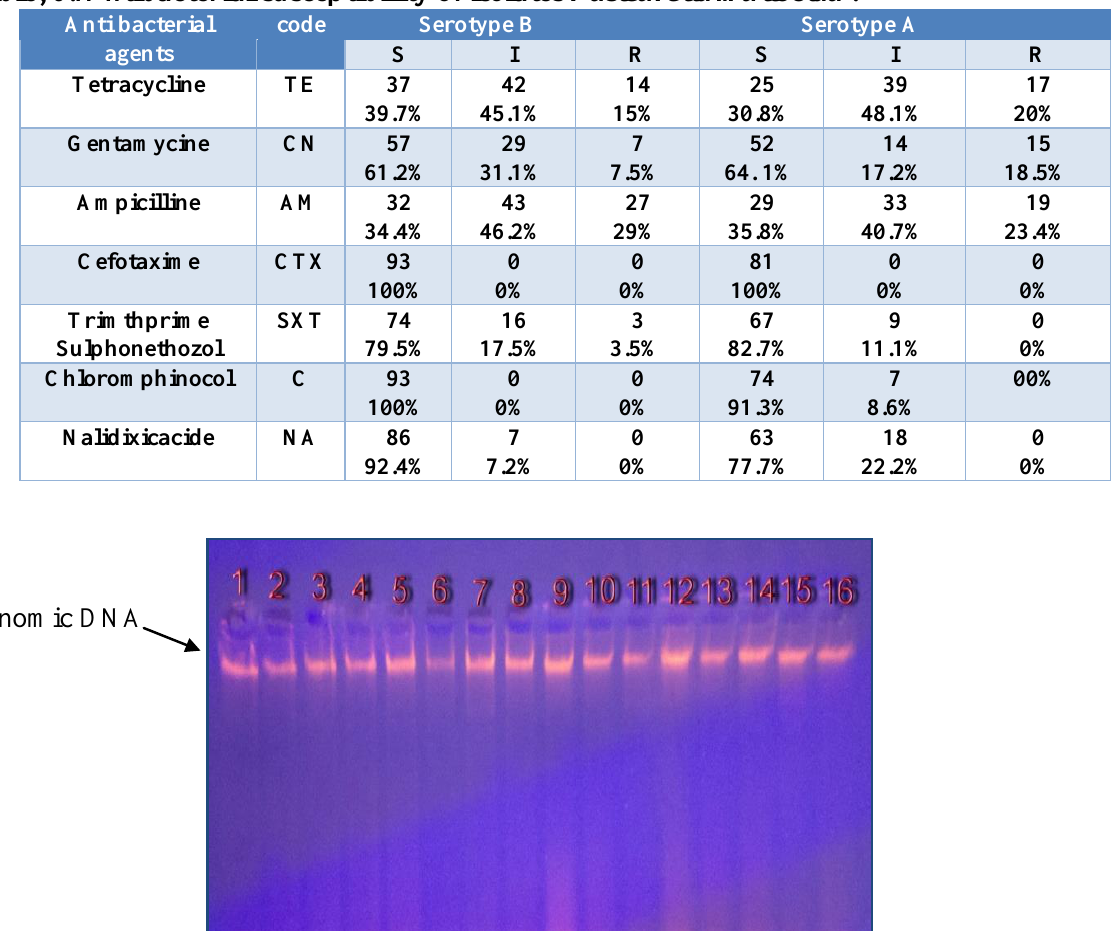
Table, 6:A ntibacterial susceptibility of isolates Pasteurella multocida .